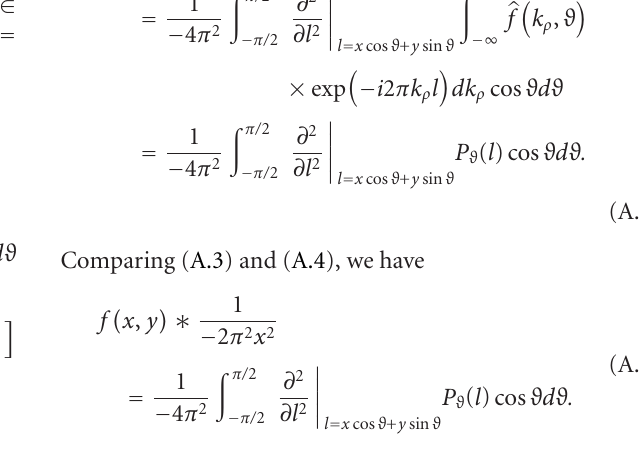
Defining the signed polar coordinates ( k ρ , ϑ ) with k ρ